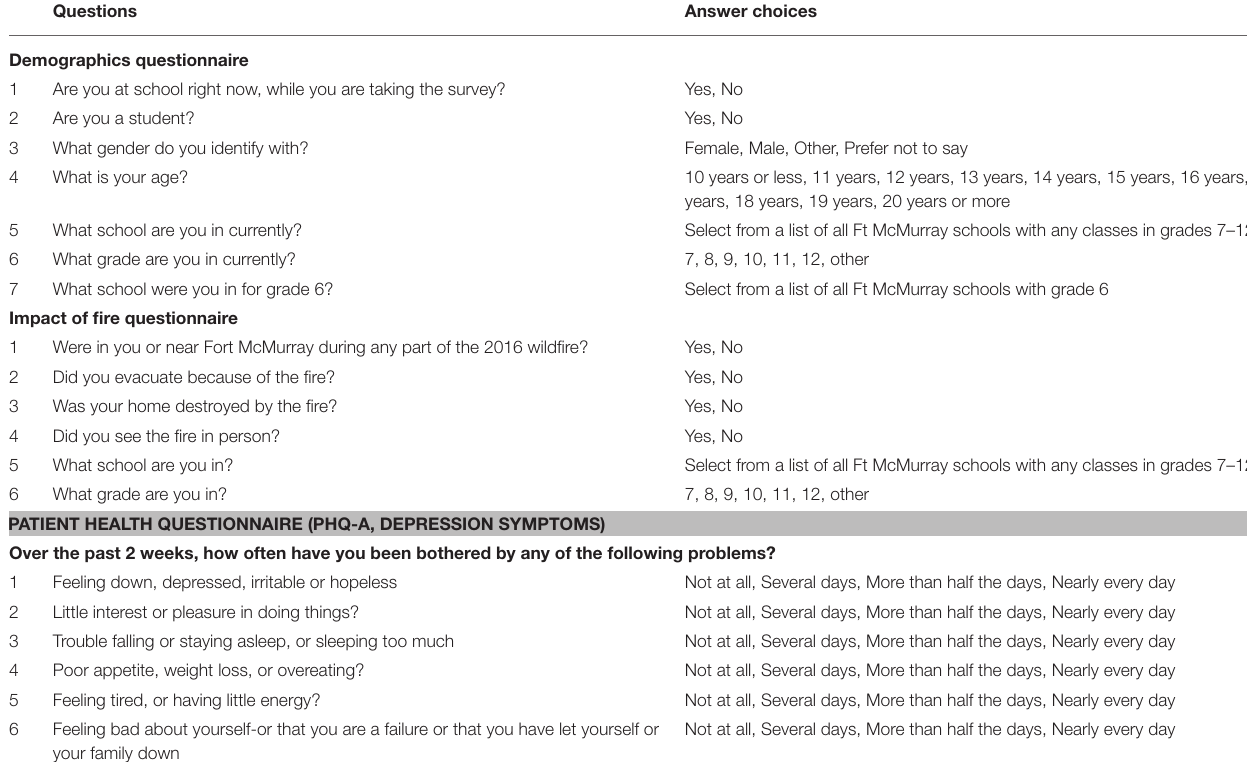
TABLE 1 | Questionnaire details [table reproduced with permission from our previously-published paper Brown et al. (13)]. Questions Answer